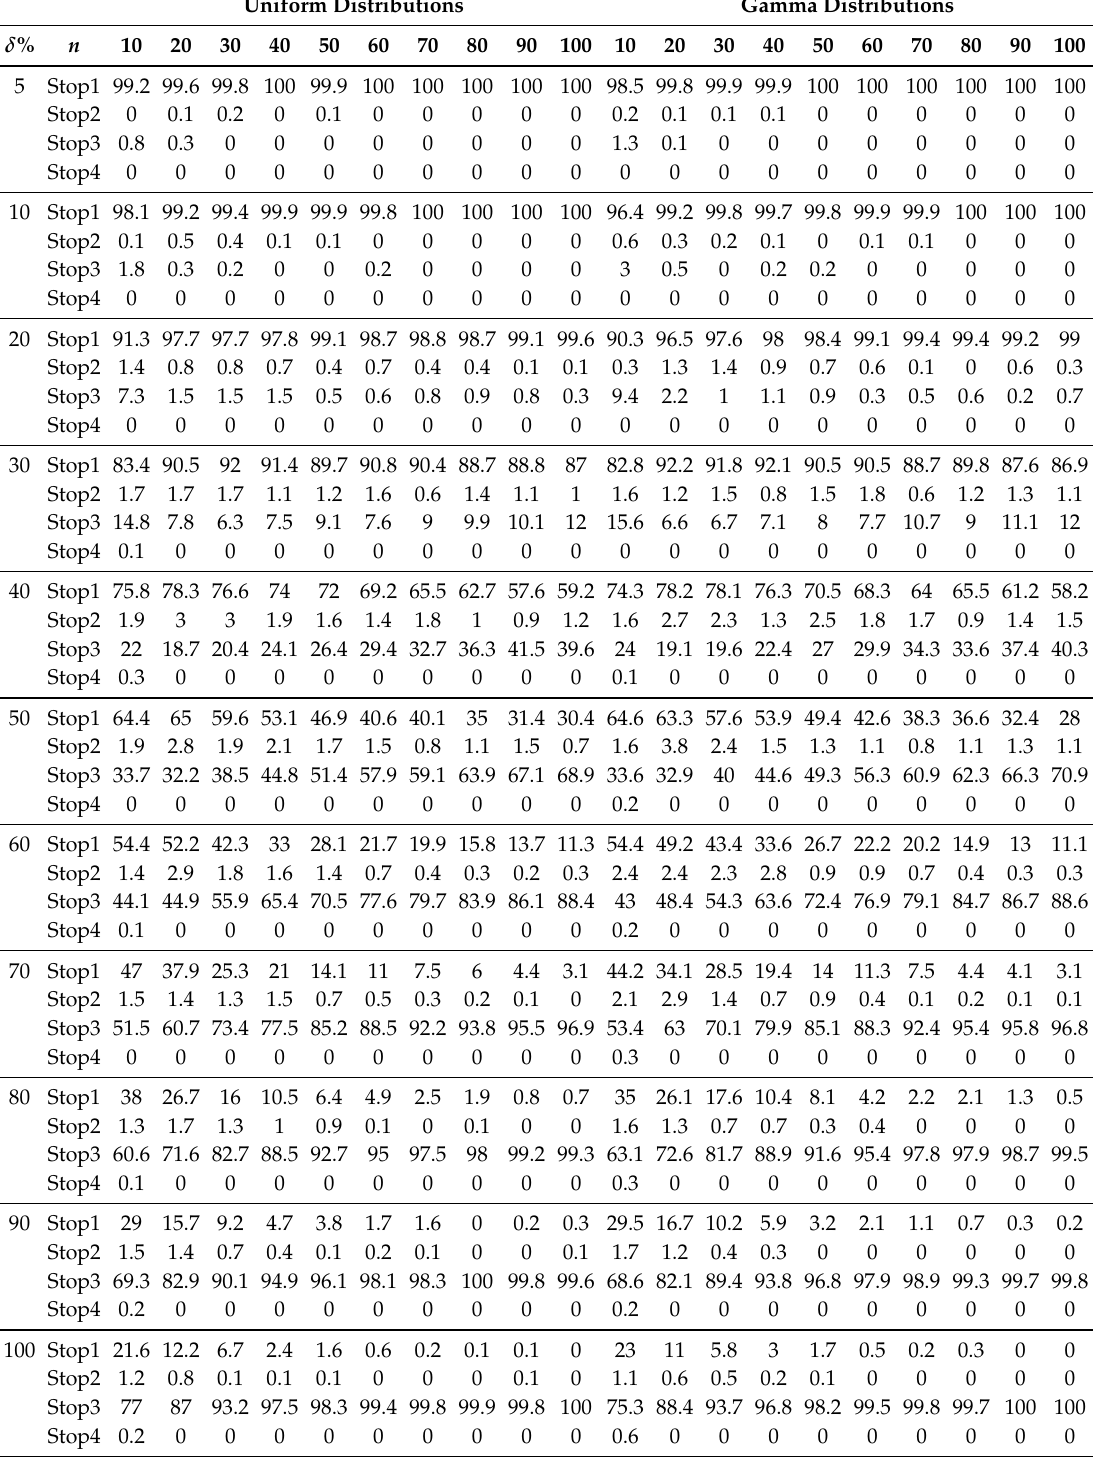
Table A11. Computational results for randomly generated instances with the ratio 10%:20%:10%:60% of the numbers of jobs in the subsets J 1 , J 2 , J 1,2 and J 2,1 of the job set J . Uniform Distributions Gamma